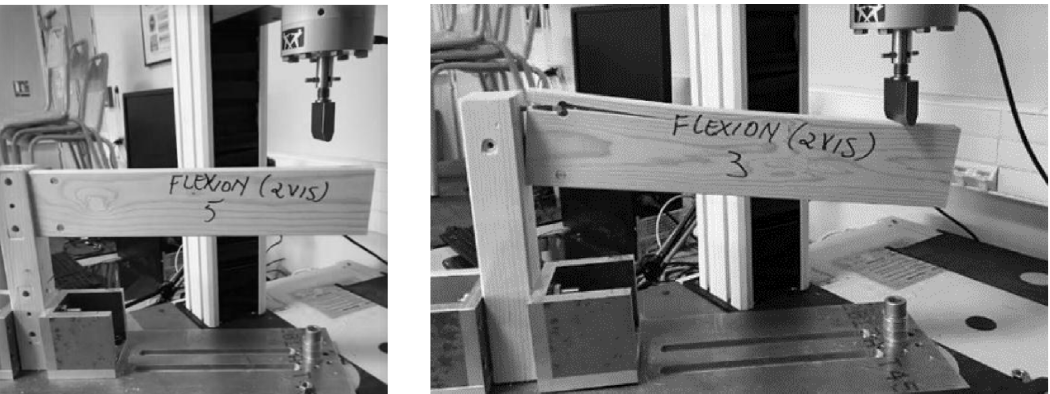
Fig. 7. Two-screws assembly: (left) experimental test con fi guration and (right) resulting failure